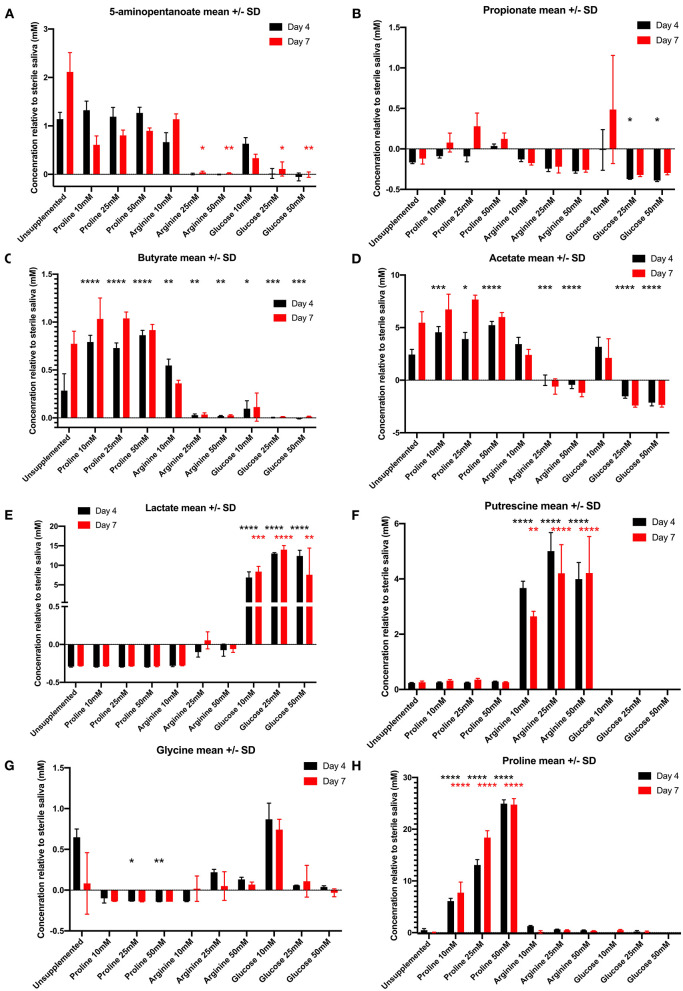
Concentration of metabolites (mean ± standard deviation) in day 4 (black bars) and day 7 (red bars) in unsupplemented and supplemented biofilms relative to the sterile saliva media. Negative concentrations (less than zero) indicate the metabolite has been consumed from the sterile saliva growth medium by bacteria in biofilms. (A) 5-aminopentanoate, (B) propionate, (C) butyrate, (D) acetate, (E) lactate, (F) putrescine, (G) glycine, (H) proline (n = 3; *p < 0.05, **p < 0.005, ***p < 0.0005, ****p < 0.0001).